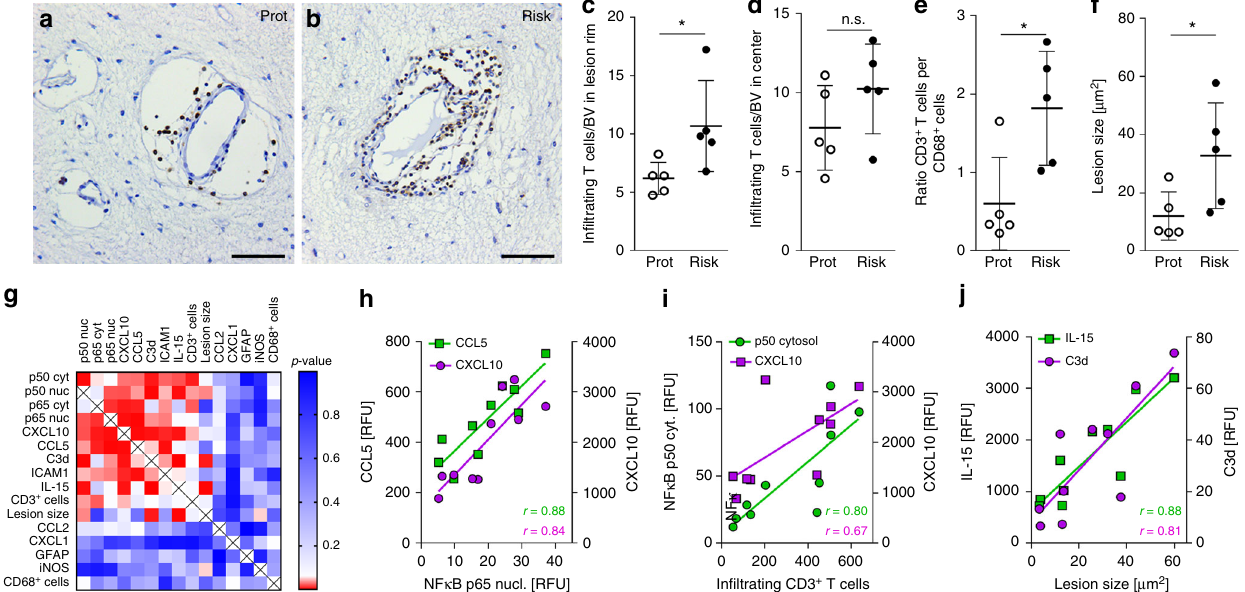
Fig. 5 Effect of the rs7665090 G variant on MS lesion pathology. a , b Bright- fi eld images of perivascular in fi ltrates within chronic active MS lesions labeled with anti-CD3 antibody. Scale bar = 50 µ m. c , d Quanti fi cation of in fi ltrating, perivascular CD3 + T cells per blood vessel in the rim ( c ) and center ( d ) of 29 lesions (15 risk group, 14 protective group) from 10 MS cases (5 cases per group) shows a signi fi cant difference between groups in the rim ( p = 0.0413), but not in the center ( p = 0.1943). Dots represent average CD3 + T cells per blood vessel for all lesions of a single case. The number of lesions from each case ranged from 1 to 5. e Ratios of perivascular CD3 + T cells to CD68 + microglia in the rim show a signi fi cant difference between groups ( p = 0.0199). f Quanti fi cation of lesion sizes, determined as area of demyelination, shows a signi fi cant difference between groups ( p = 0.0491). Dots represent average size for all lesions of a single case. Data represents mean ± s.d. p -Values shown for the unpaired t -test. * p < 0.05. g Heatmap of computed Pearson correlation coef fi cients from expression values of 5 cases per group (red, p -value < 0.05; blue, p -value > 0.05). h Correlation of NF- κ B p65 nuclear expression with CCL5 ( r = 0.88, p = 0.001) and CXCL10 ( r = 0.84, p = 0.003) expression in astrocytes. i Correlation of in fi ltrating CD3 + T cell with cytosolic NF- κ B p50 ( r = 0.80, p = 0.005) and CXCL10 ( r = 0.67, p = 0.036) expression. j Correlation of lesion size with IL-15 ( r = 0.88, p = 0.001) and C3d ( r = 0.81, p =